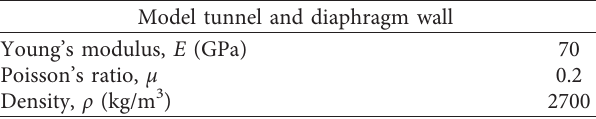
Table 2: Model parameters for tunnel and diaphragm wall. Model tunnel and diaphragm